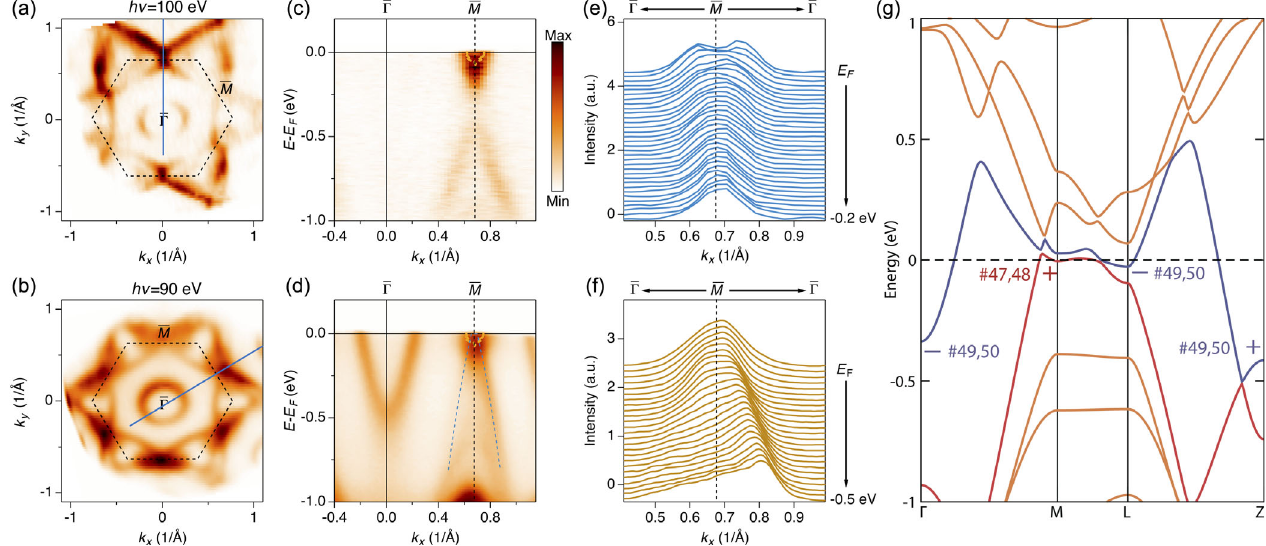
FIG. 4. 3D-CDW-induced band inversion. (a) and (b) show Fermi-surface maps measured at photon energies of h ν ¼ 100 and 90 eV ¼ π and 0 . 15 π around the ¯ M point, respectively. Data are taken at T ¼ 15 K. The blue lines in (a) and (b) mark corresponding to k z the high-symmetry cuts shown in (c) and (d), respectively. The inner potential is extracted to be around 8.2 eV (see Supplemental Material [31]). (c) and (d) selectively enhance the electron band near the unfolded L point and the hole band near the unfolded M point. The yellow dots in (c) and (d) are extracted from the MDC peaks shown in (e). The blue dashed line in (d) is a guide to the eye. The blurry spectral weight near the Fermi level in (d) likely comes from the bulk projected surface state [8]. (e) and (f) show stacking plots of MDCs to further reveal the electron and hole bands in panels (c) and (d). (g) shows the electronic band structure of RbV 3 Sb 5 calculated by VASP [45 – 47] after a full relaxation on atomic positions with an atom pairwise-correction method (DFT-D3) [48] since the van der Waals forces play an important role along the c -layer stacking direction. The Fermi energy is shifted by 100 meV in order to match the experimental results. There is a hole pocket in the vicinity of the M point ( Γ - M direction) carrying a parity of “ þ ” and an electron pocket in the vicinity of the L point carrying a parity of “ − ” contributed by different bands. Our DFT result confirms the parity distribution of the band structure that is reported to possess a nontrivial Z 2 topological invariant and induce topological surface states around the M point